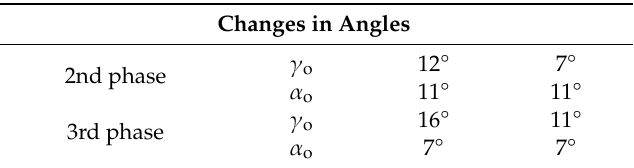
Table 2. Changes in the angles’ values.